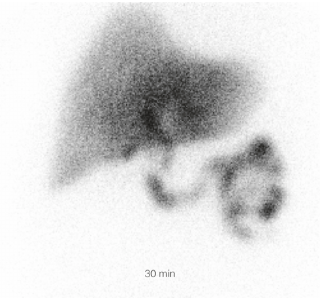
Figure 2: Image obtained during HIDA scan shows early filling of the gallbladder by 30 minutes which was confirmed on delayed 40- and 60-minute images.